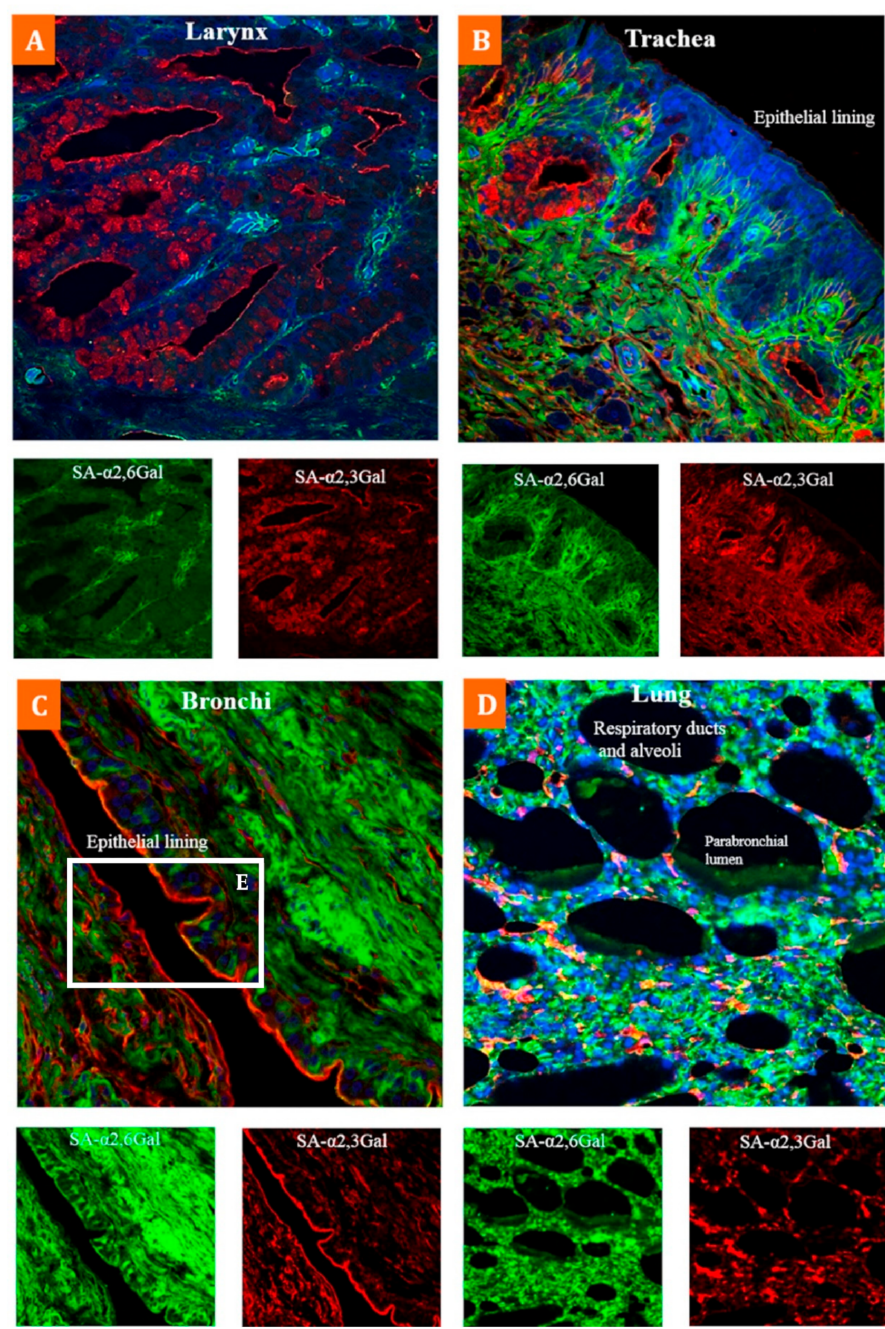
Figure 1. Co-expression of α -2,3 SA and α -2,6 SA receptors in the emu respiratory tract: Composite confocal images show an abundant co-expression of α -2,6 SA receptors (green) and α -2,3 SA receptors (red) throughout the emu respiratory tract. Comparable expression of both receptor types was observed in the ciliated epithelial cells, goblet cells and non-ciliated epithelial cells of ( A ) larynx, ( B ) trachea, ( C ) bronchi and ( D ) alveoli of lungs. Tissue sections stained with biotinylated MAAII (red-specific for α -2,3-Gal SA) and FITC labelled SNA (green-specific for α -2,6-Gal SA) lectins, and nuclear staining with DAPI (blue). Adapted with permission from ref. [60]. Copyright 2017